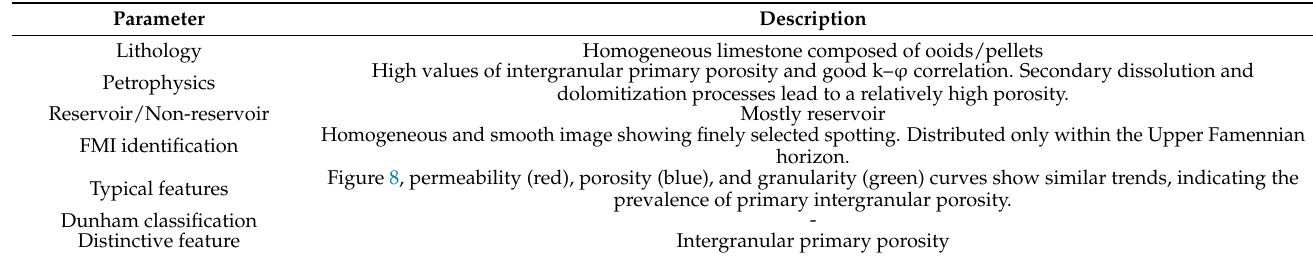
Table 5. Description of main reservoir parameters for